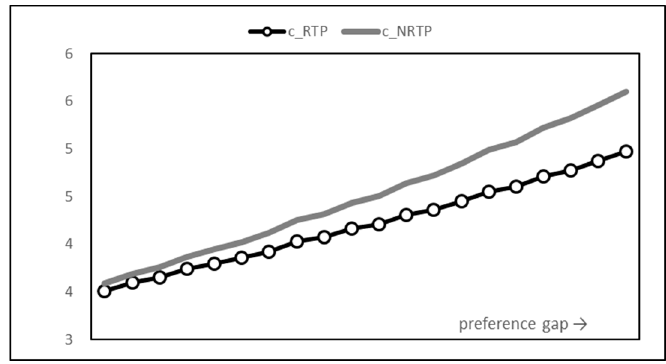
Figure 14. Total production cost graph.